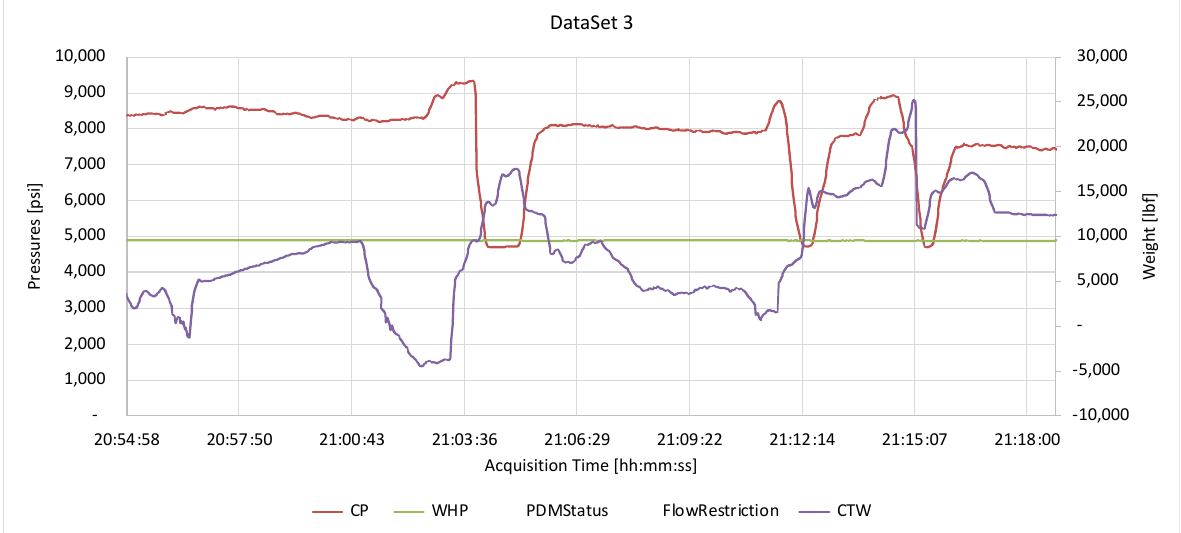
Figure 12. Plot for Dataset 3 datapoints and FIS outputs.